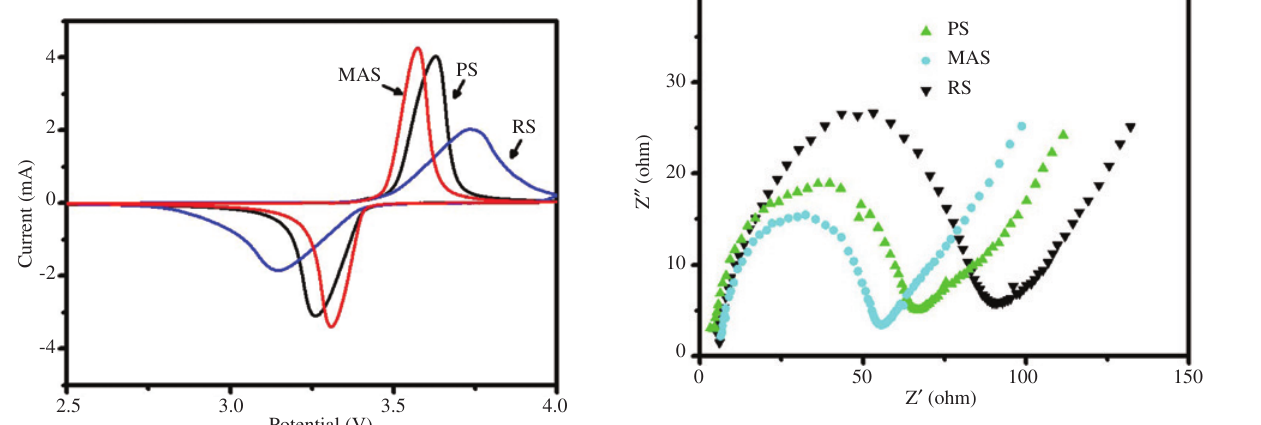
Figure 5: CV profiles of samples at 0.1 mV/s scan rates.